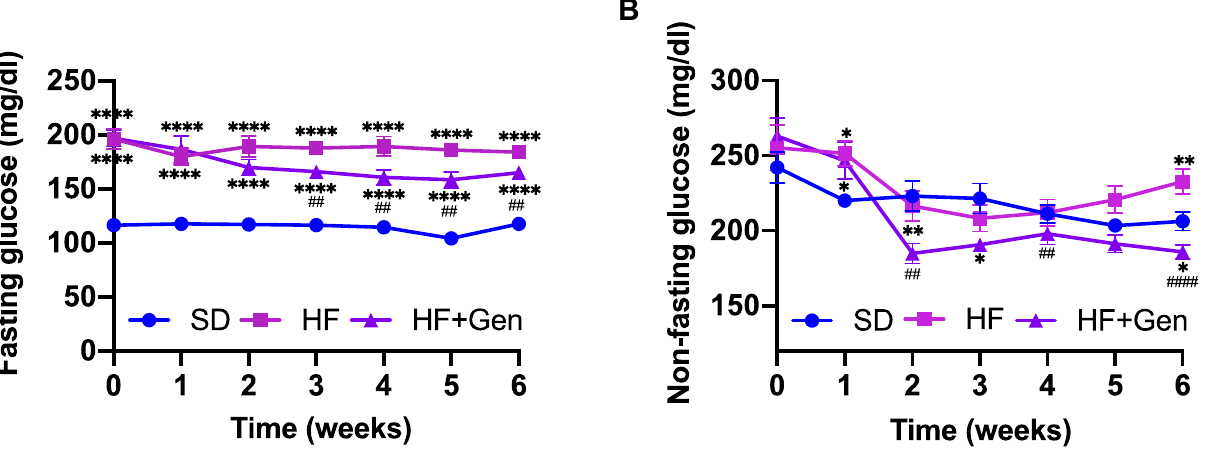
Figure 4. Genipin ameliorated hyperglycemia in HFD-induced obese mice. Mice were fed an HFD or SD for 10 weeks, and were then given 50 mg/kg genipin or vehicle via oral gavage. Fasting blood glucose (A) and non-fasting blood glucose (B) were measured weekly during the treatment. Data are presented as mean ± SEM (n = 12 mice for SD group, 11 mice each for HF and genipin-treated (HF + Gen) groups). * p < 0.05, ** p < 0.01 and **** p < 0.0001 vs. SD mice; ## p < 0.01, #### p < 0.0001 vs. HF mice.